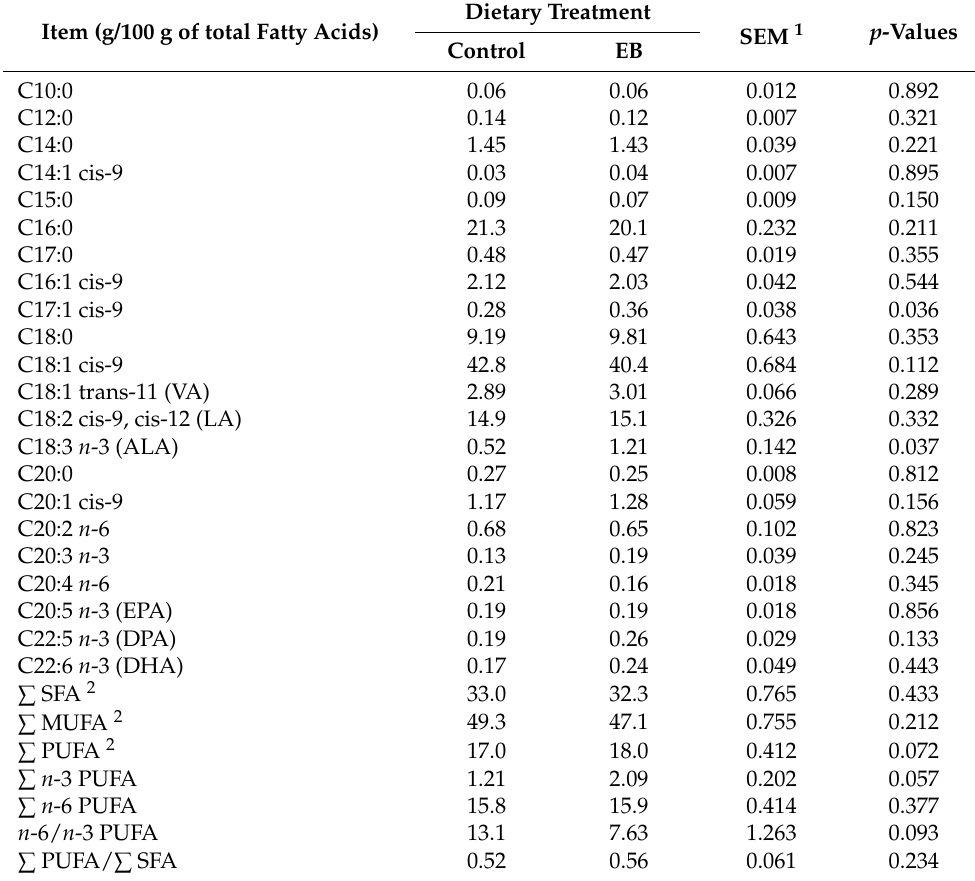
Table 5. Effect of the exhausted bergamot by-product on back-fat fatty acid profile. Item (g/100 g of total Fatty Acids)